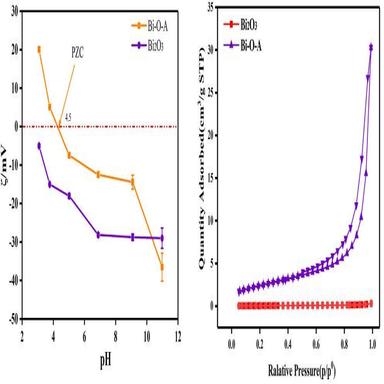
(a) Variation of Bi–O-A and Bi2O3 Zeta potential, (b) BET of Bi–O-A and Bi2O3.